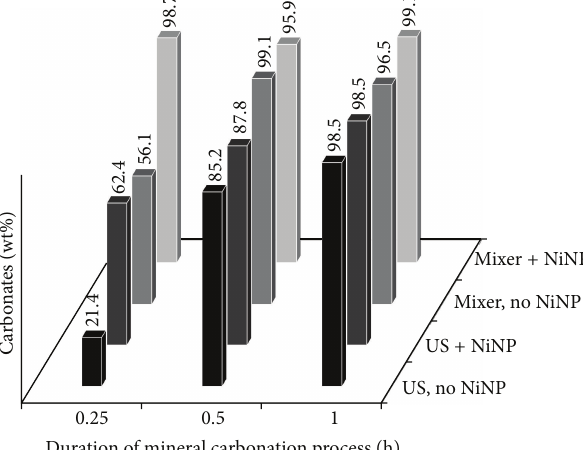
Figure 2: Carbonate content after MgO mineral carbonation, using S/L ratio of 7.19g/1000 mL, determined by